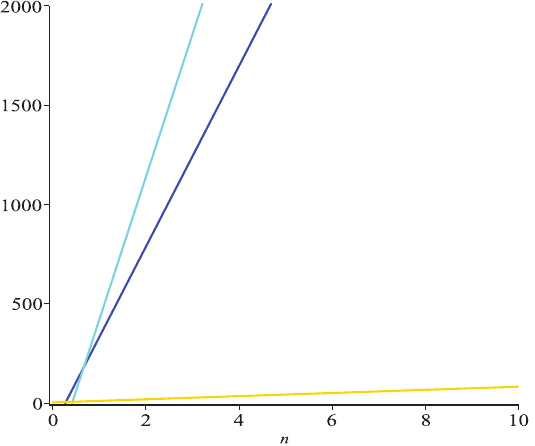
Figure 6: Graphical comparison of M labeled in blue, cyan, and gold graphs, respectively, for MON ( n ). 1